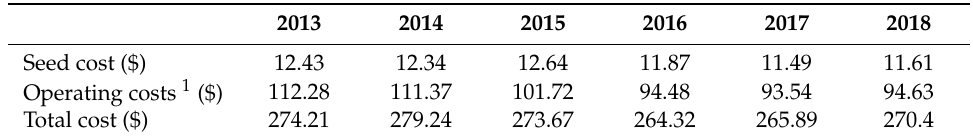
Table 3. Seed and total cost for